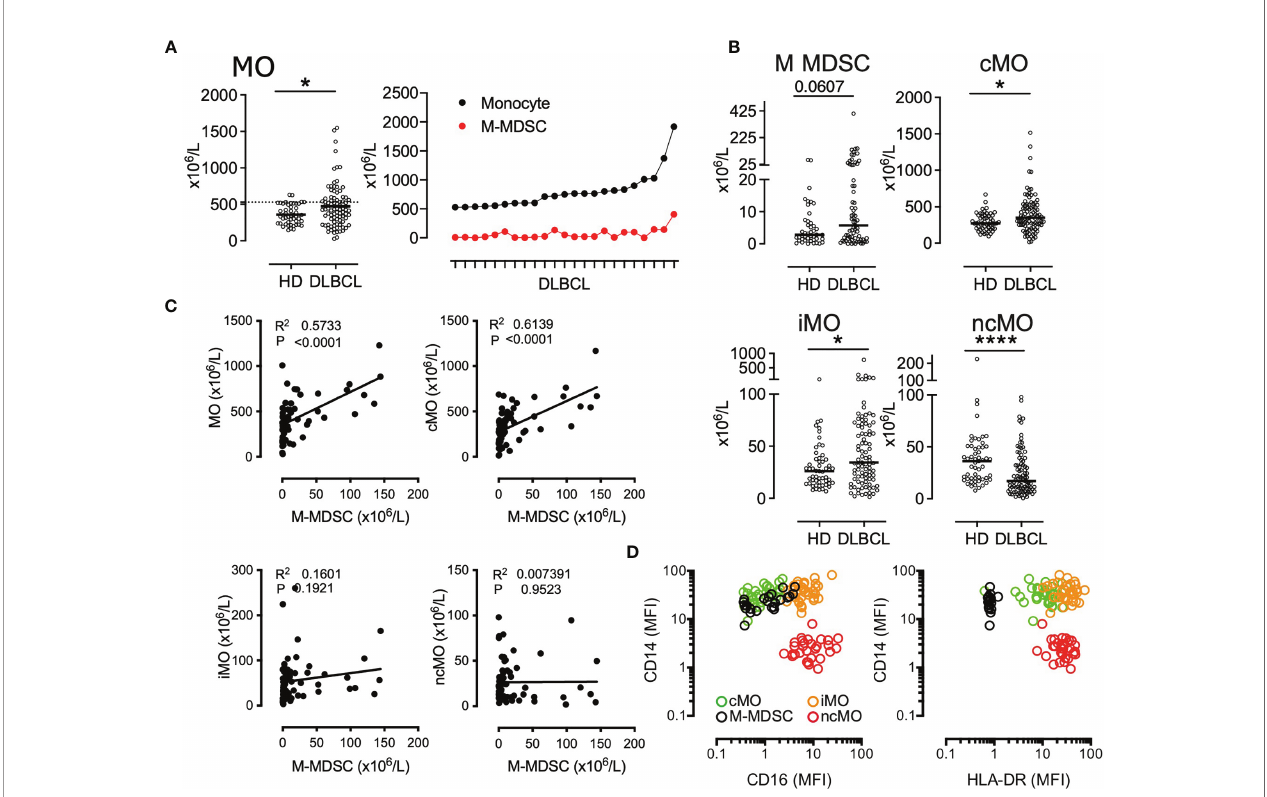
FIGURE 1 | cMO and iMO are increased in peripheral blood from DLBCL. (A) Monocyte absolute counts in HD (n = 49) and DLBCL (n = 88). For the 23 DLBCL samples with monocyte above 528 x10 6 monocytes/L (corresponding to the 90 th percentile of HD), proportion of M-MDSC within monocyte (B) M-MDSC in HD (n = 43) and DLBCL (n = 69) and monocyte subset counts [classical- (cMO), intermediate- (iMO), and nonclassical- (ncMO)] in peripheral blood from HD (n = 55) and DLBCL patients (n = 91). (C) Pearson correlation between M-MDSC and monocyte (MO), cMO, iMO, and ncMO (n = 68). (D) Mean fl uorescent intensity (MFI) for CD14, CD16, and HLA-DR. Each dot represents a DLBCL sample (n = 33) colored by monocyte subset (MDSC, cMO, iMO, and ncMO). Mann-Whitney test were performed. *P <. 05, ****P <